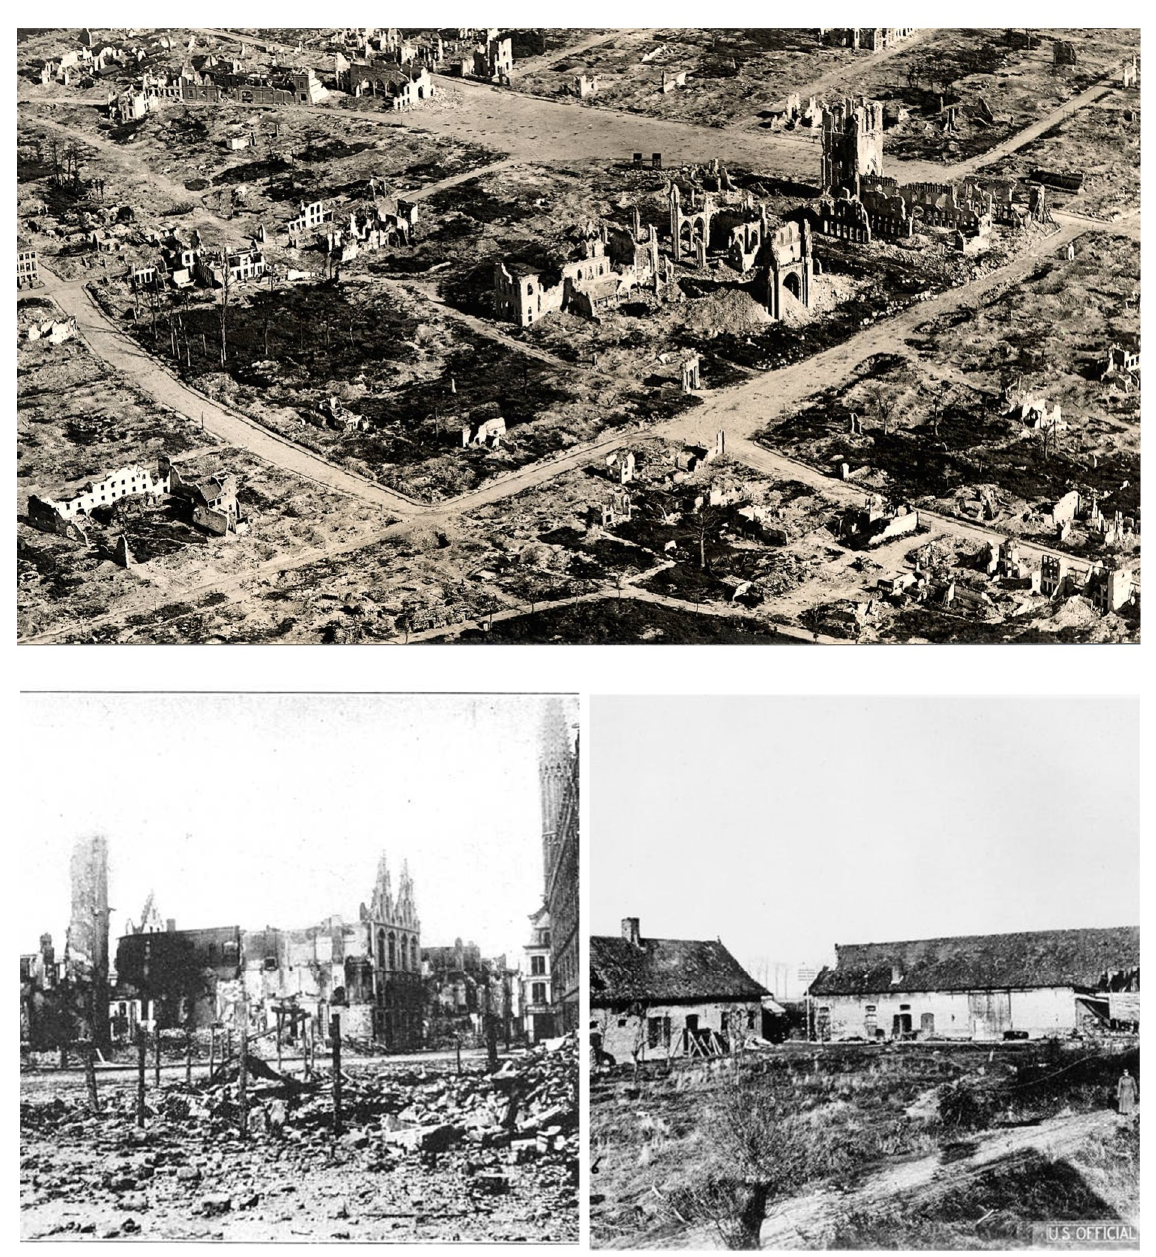
Figure 1. Aftermath of World War I in the city of Ypres and surrounding landscape.